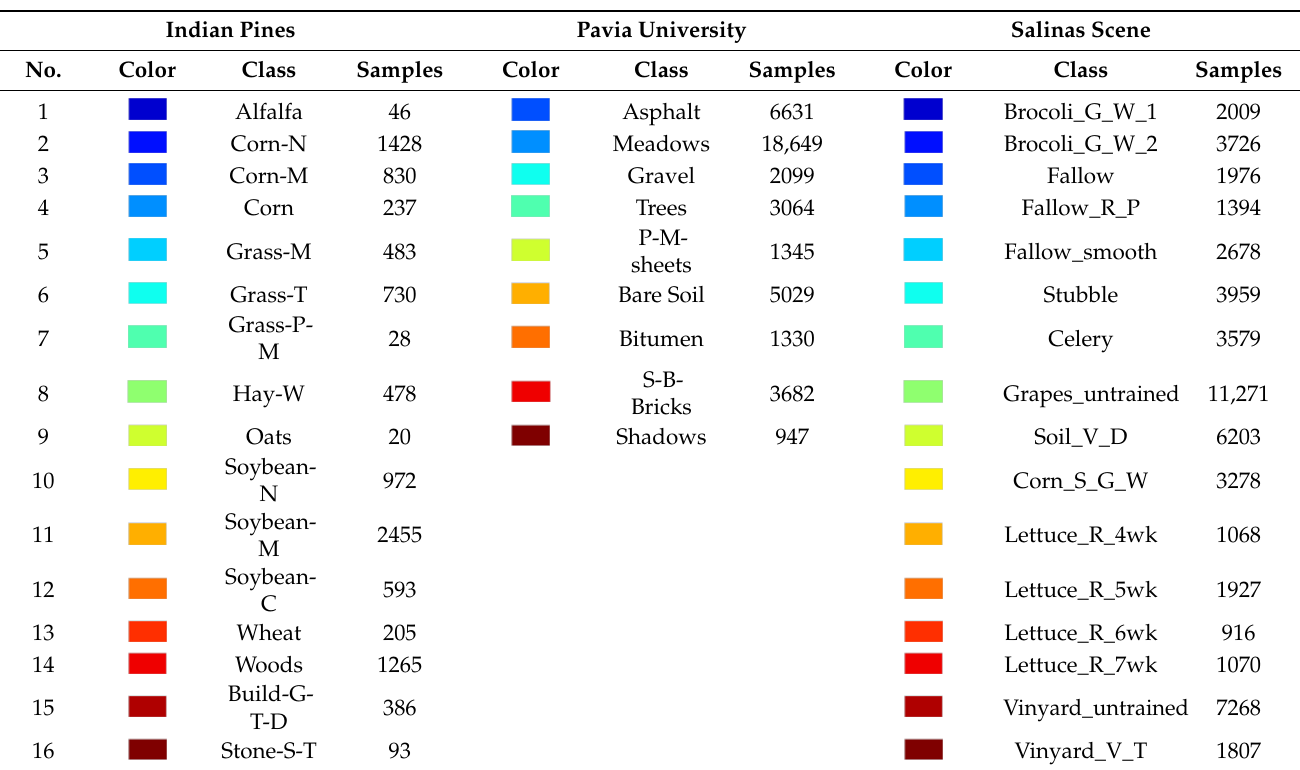
Figure 8. Salinas scene dataset. ( a ) The false-color image. ( b ) The ground-truth map. Table 1. Information of each category in three datasets.